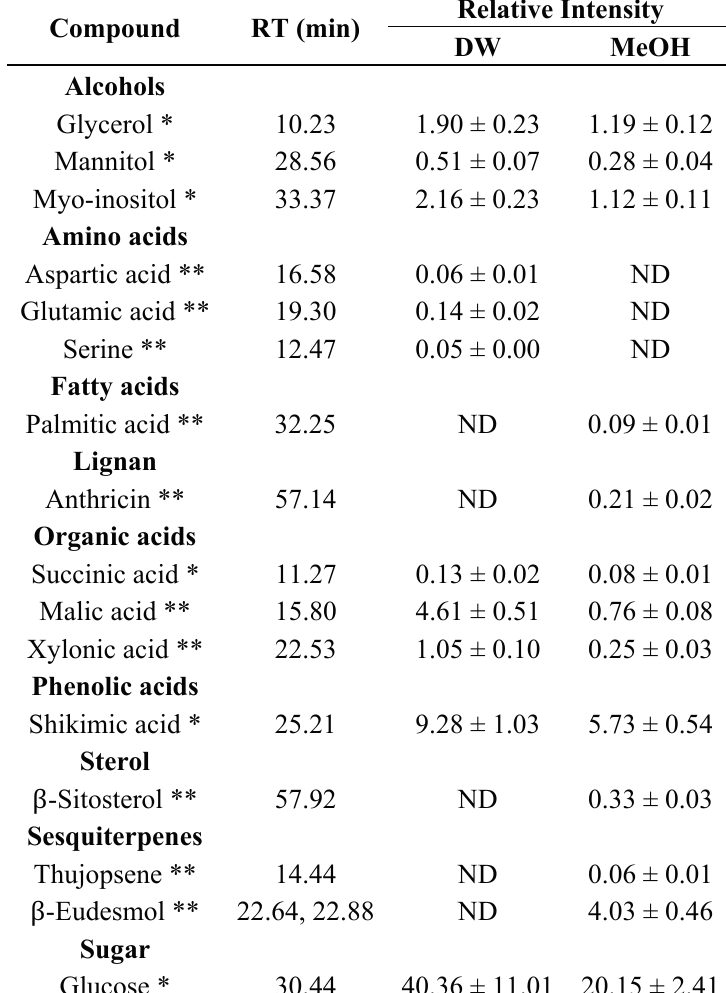
Figure 3. Principal component analysis (PCA)-derived score plots of methanol and water extracts of Chamaecyparis obtusa leaves using five biological replicates. Table 1. Relative intensity of various metabolites in the methanol (MeOH) and distilled water (DW) extracts of Chamaecyparis obtusa leaves. All data are presented as mean ± standard error of the mean of five replicates. * p < 0.05 (student’s t -test); ** p < 0.01 (Student’s t -test). RT, retention time; ND, not